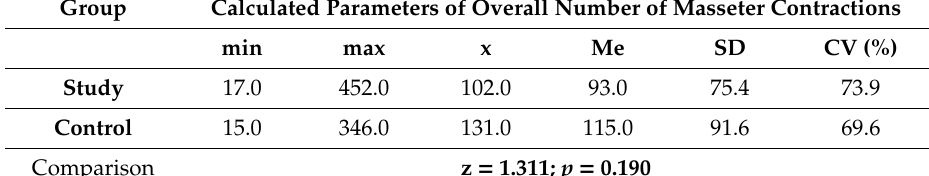
Table 6. Comparison of mean masseter muscle contractions in patients in the study group and in the control group. Group Calculated Parameters of Overall Number of Masseter Contractions